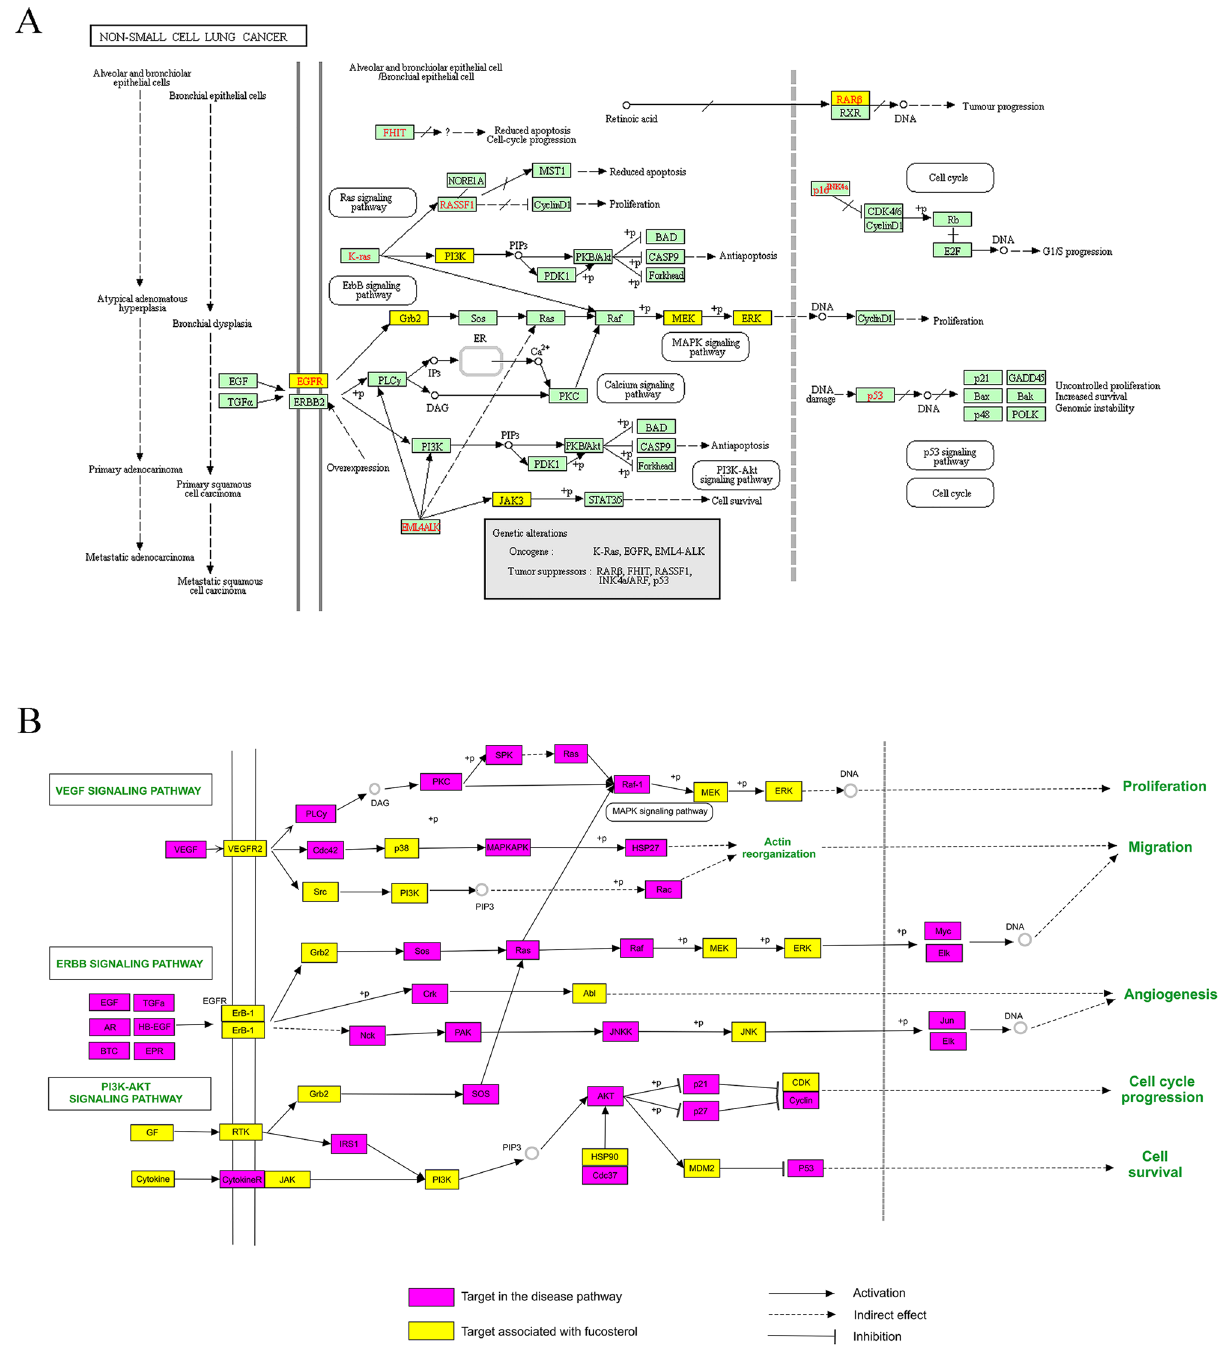
Figure 8. The integrated pathways map of fucosterol in the treatment of NSCLC include ( A ) the non-small cell lung cancer pathway, marked in yellow as the functional targets of fucosterol, and ( B ) the key signal transduction